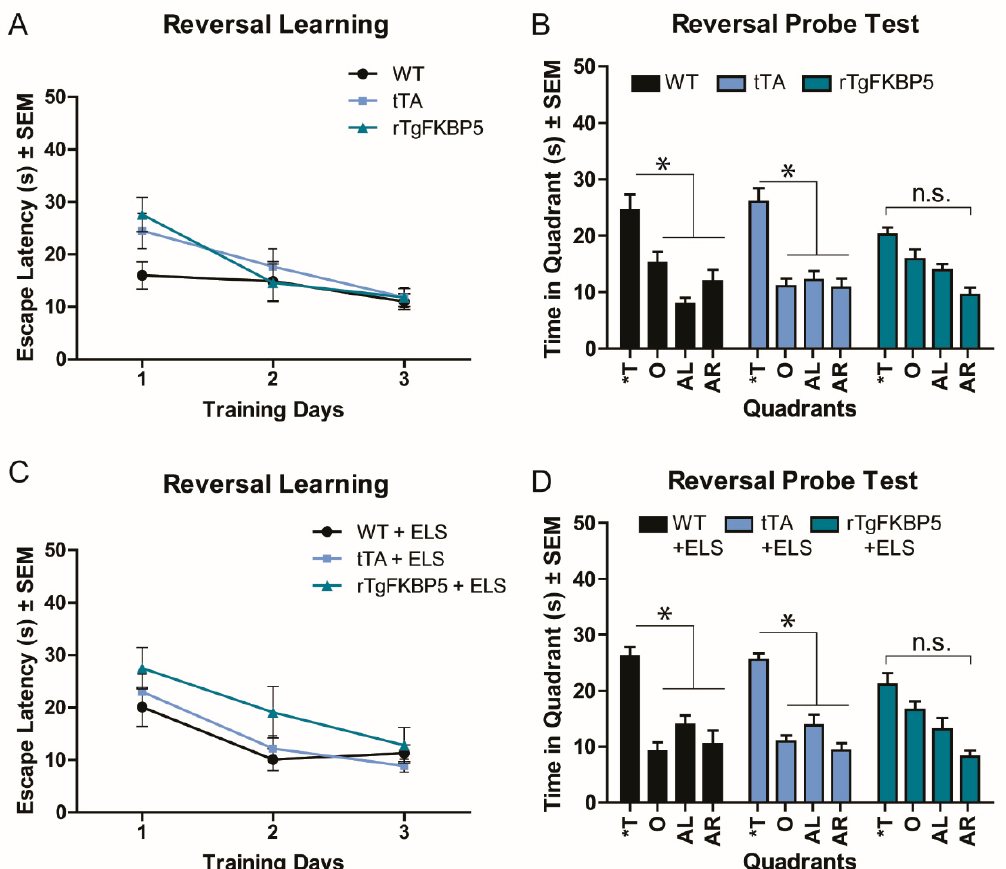
Figure 3. Deficit in spatial reversal learning is attributed to high levels of FKBP5 independently of stress. Spatial reversal memory analysis of non-stressed mice (WT = 11, tTA = 10, TgFKBP5 = 9) during ( A ) training days and ( B ) probe test using the Morris Water Maze (MWM) paradigm. Data analysis for spatial reversal learning of early stressed mice (WT = 10, tTA = 10, rTgFKBP5 = 10) during ( C ) training days and ( D ) probe test. Each training day represents a block of 4–60 s trials. s = seconds, ELS = early life stress; Quadrants: T = target, O = Opposite, AR = adjacent right, AL = adjacent left. SEM = standard error of the mean, n.s. = non-significant. Data were analyzed by two-way ANOVA followed by Bonferroni post-hoc tests where significant results are represented as * = p < 0.05. Refer to Supplementary Material File S3 for MWM spatial learning and memory testing and Table 1 for three-way ANOVA